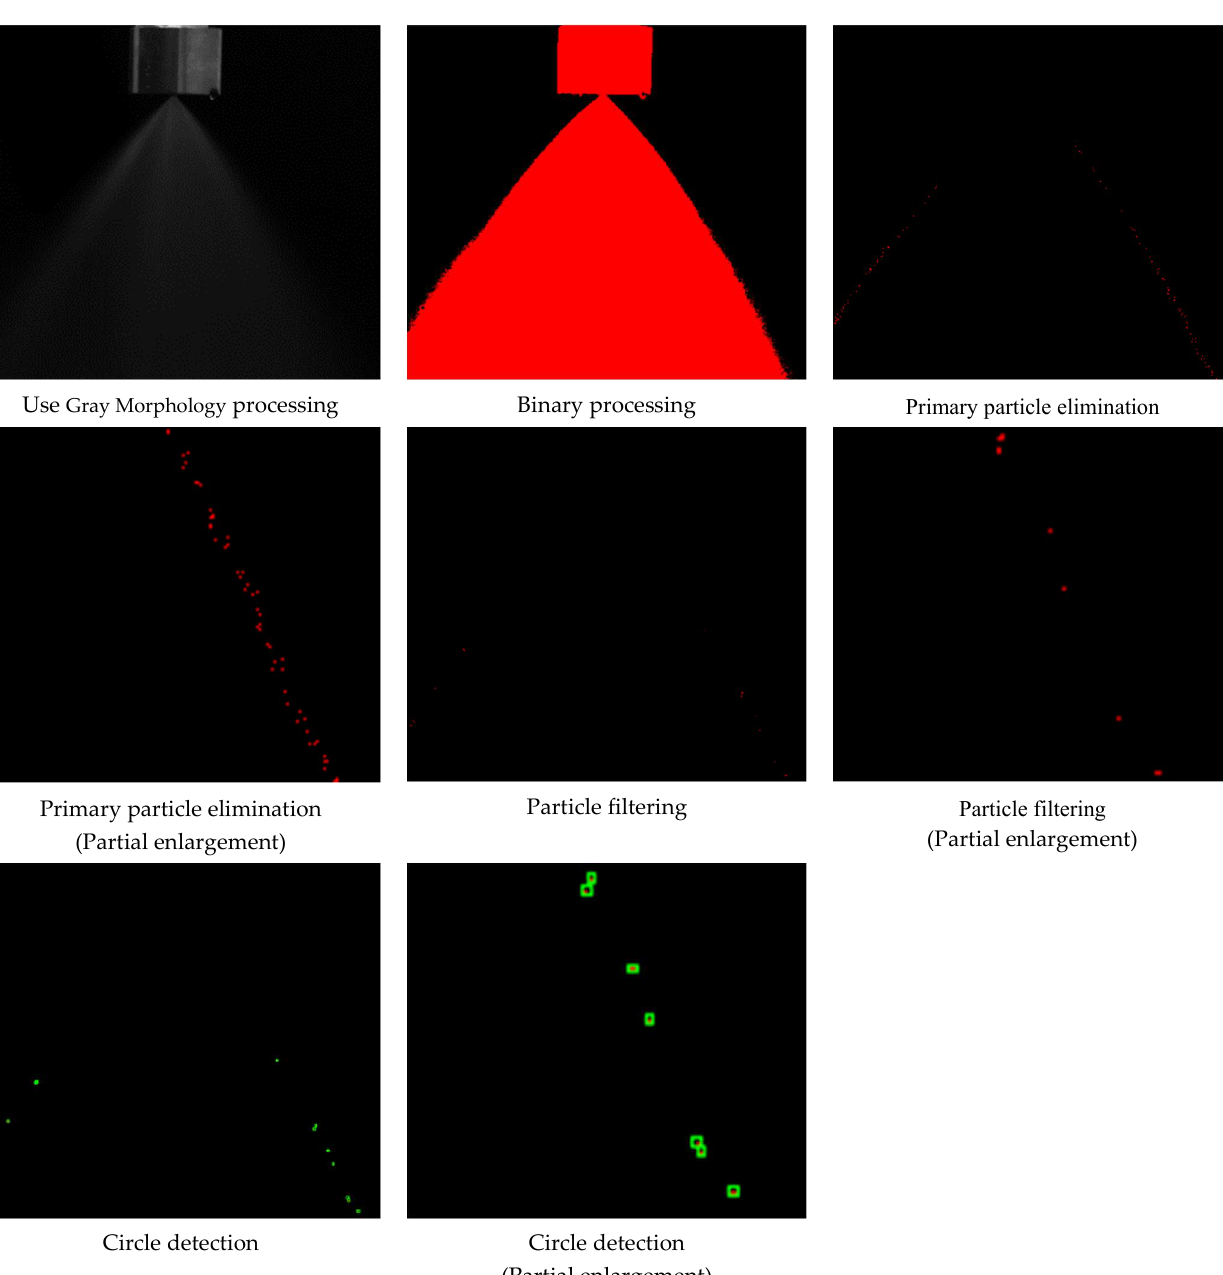
Figure 2. Image-processing method.